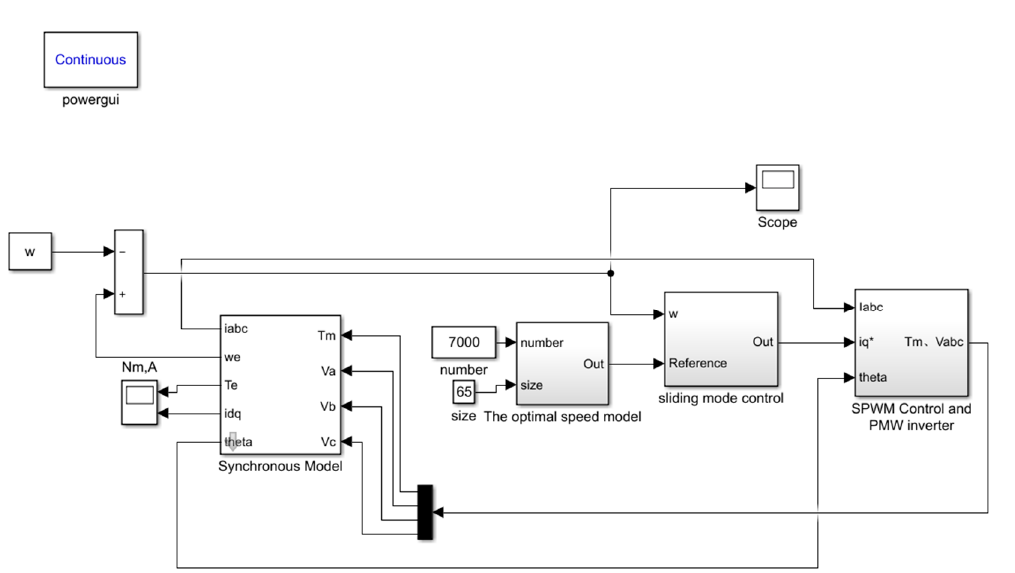
Figure 10. Motor model of the SAG mill and sliding mode control.